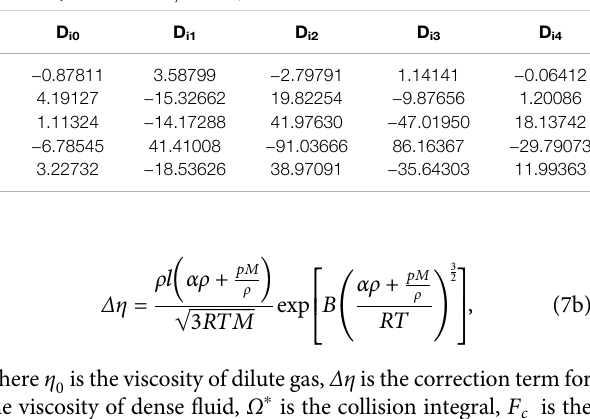
TABLE 7 | Coef fi cients D ij of T ( h , p ) .